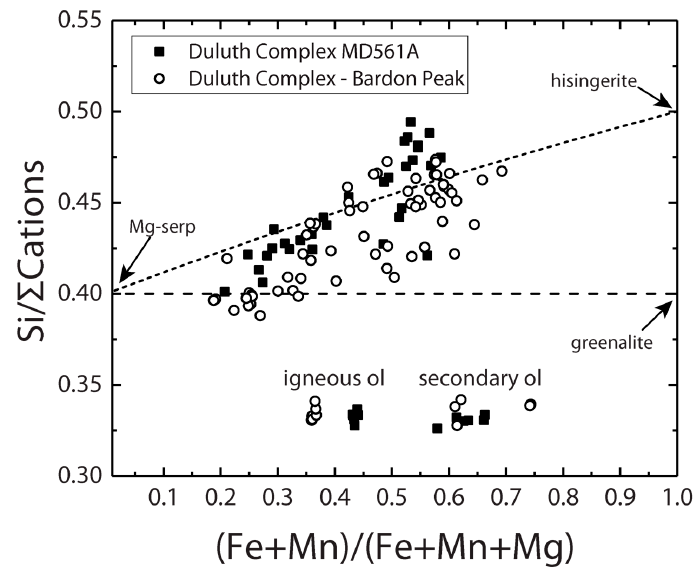
Figure 2. Formula proportions from electron microprobe spot analyses of phyllosilicate and olivine (igneous and secondary) in two Duluth Mafic Complex peridotites. Dashed lines from Figure 1.